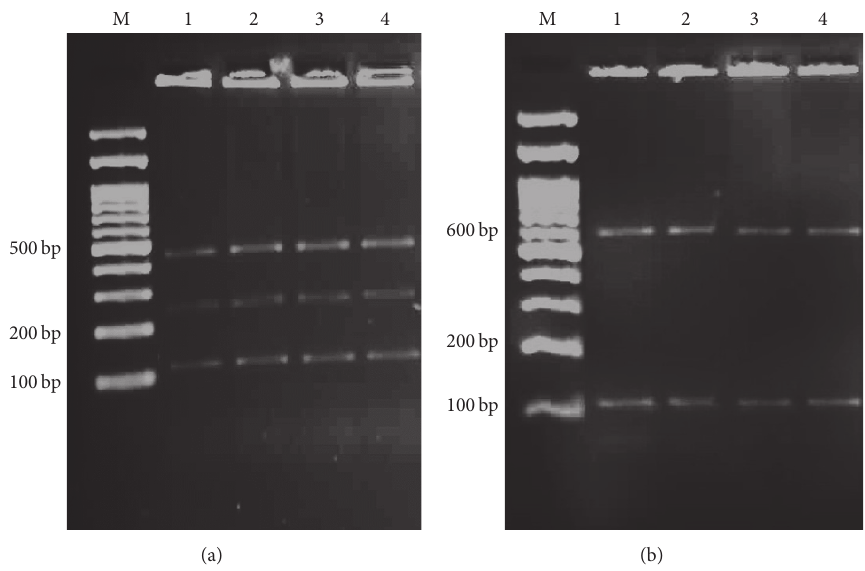
Figure 2: (a) PCR-RFLP products with SspI restriction enzyme. Three cuttings in locations 108, 258, and 421bp are visible on gel electrophoresis. (b) PCR-RFLP products with VspI restriction enzyme. Three cuttings in locations 104, 106, and 600bp are visible on agarose gel. Lane M, DNA size marker. Lane 1, positive control for Cryptosporidium . Lanes 2–4, positive Cryptosporidium samples.